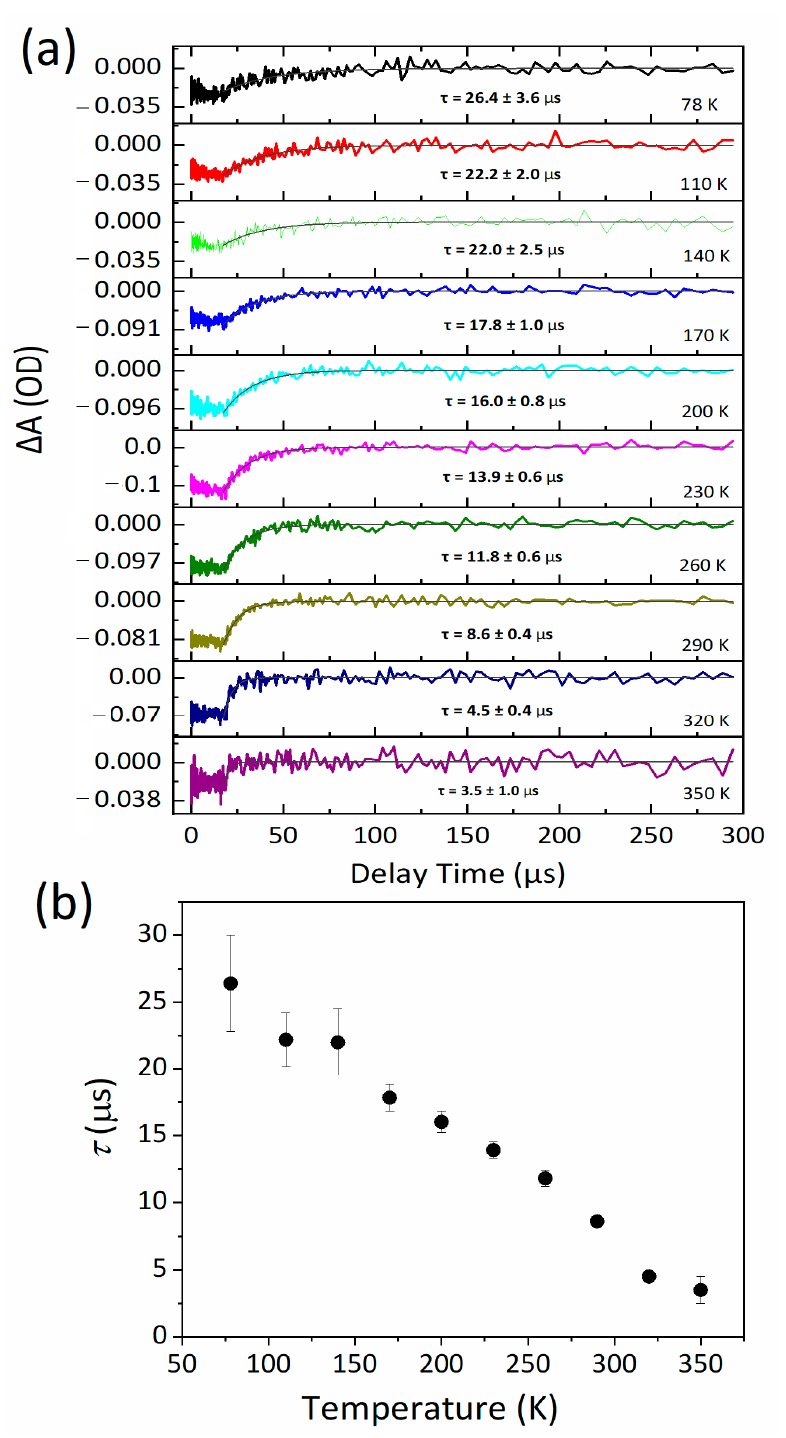
Figure 3. ( a ) The kinetic traces of [bppmCu 2 I 2 ] 2 taken at each peak of the spectral profile at different temperatures. ( b ) Temperature dependence of the decay times for the complex [bppmCu 2 I 2 ] 2 .